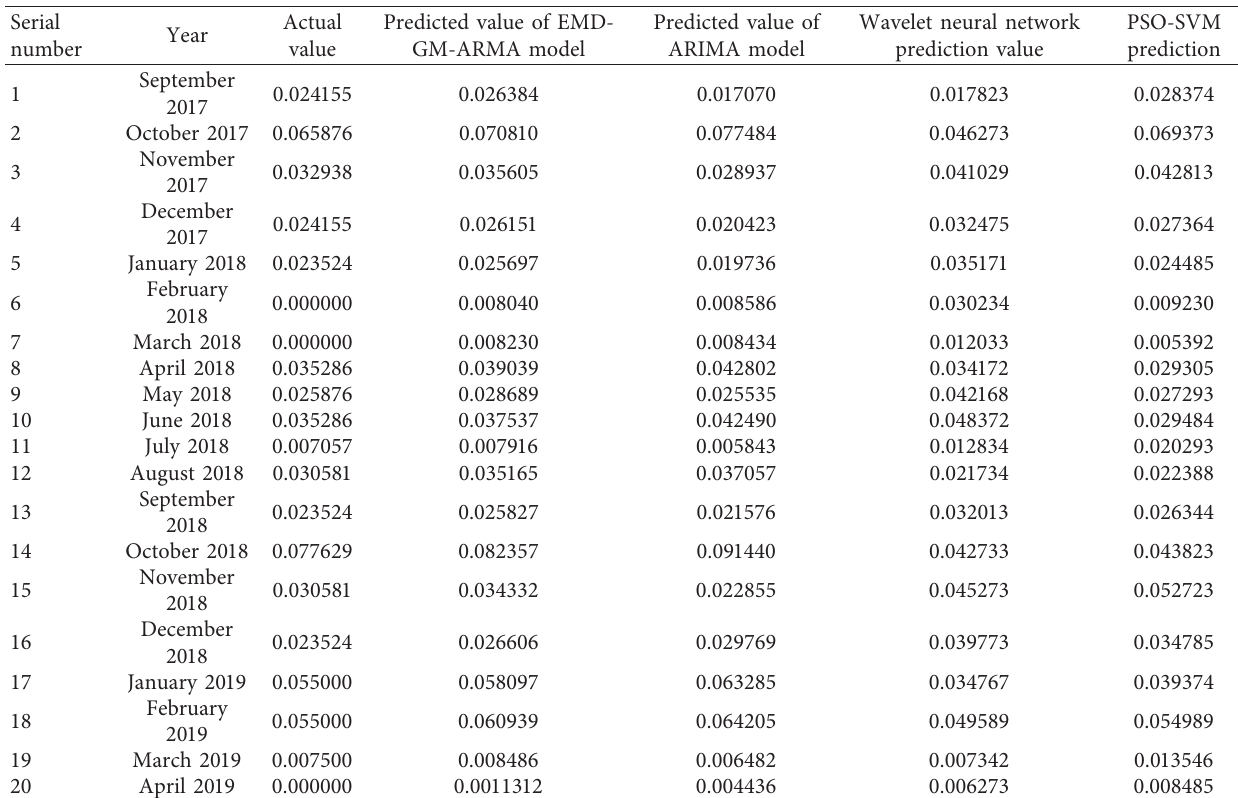
Table 3: Comparison of model prediction results.